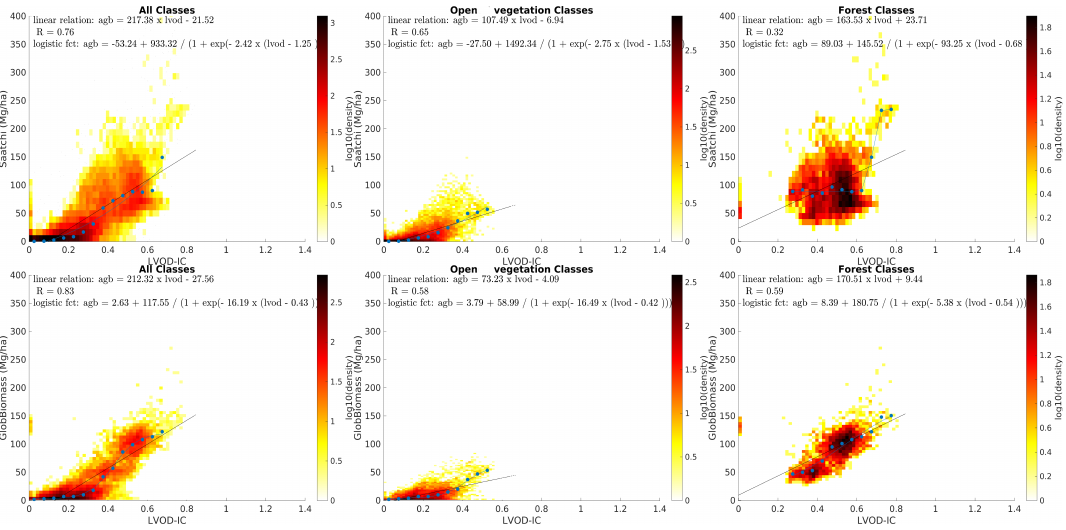
Figure 3. AGB Saatchi ( top row ) and GlobBiomass ( bottom row ) as a function of L-VOD over the northern high latitudes. left column Figures are for all IGBP classes, middle column for low vegetation classes, and right column are for forest classes.